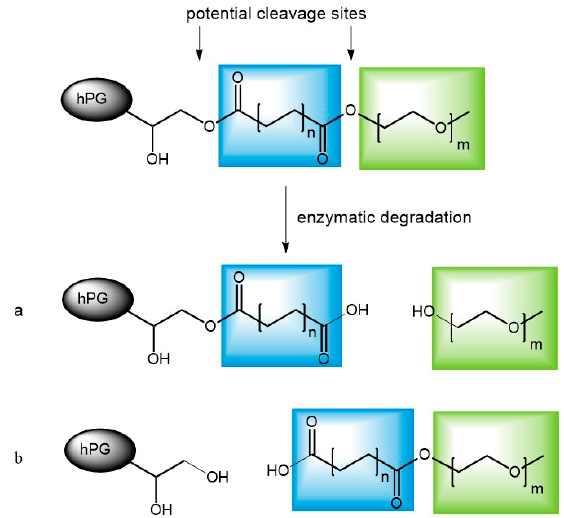
Figure 5. Different cases of ester cleavage. Depending on the site of cleavage, either the double shell ( a ) or the PEG-chain ( b ) is cleaved off.